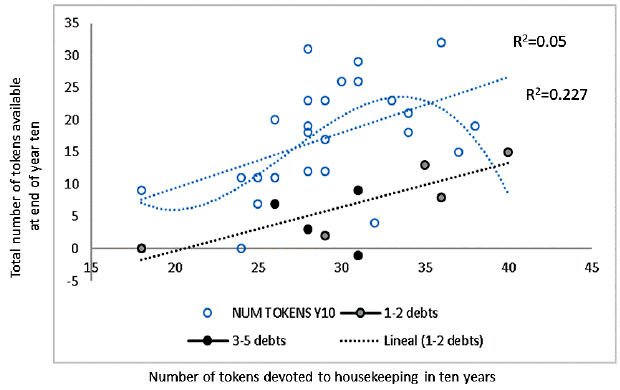
Fig. 12. Linear and polynomial regressions for the relationship between the total number of tokens devoted to housekeeping by household teams over 10 rounds) and the total number of tokens of all types obtained by the household team over 10 rounds for single-family games. N = 44 household teams; blue data points are for household teams that did not request